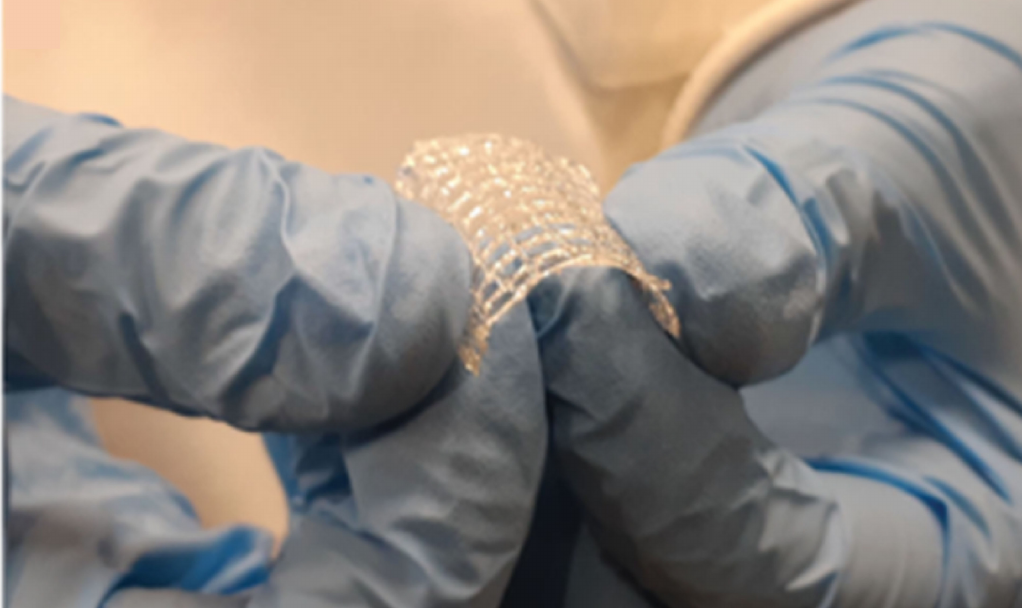
Figure 9. 3D-printed rifampicin-loaded scaffold showing great mechanical flexibility and integrity upon bending. Images reproduced with permission from